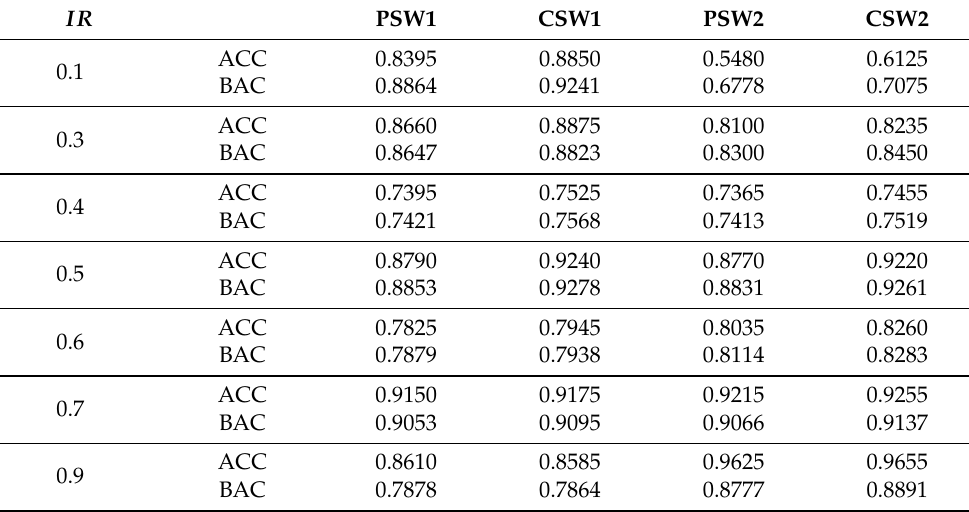
Table 3. Averaged performance of classifiers based on PBDF for simulated